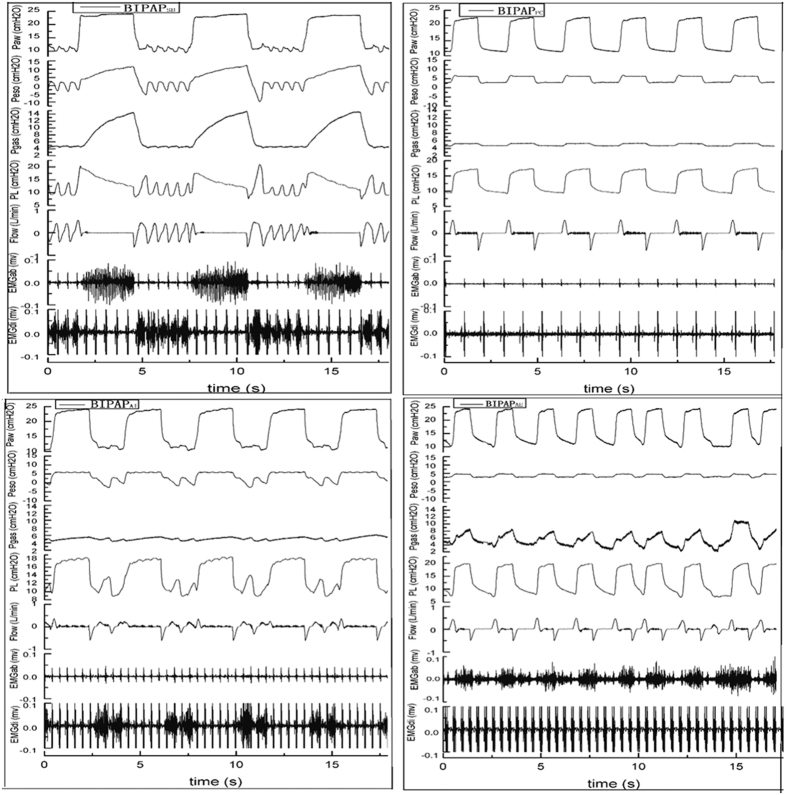
Representative respiratory tracings of airway pressure (Paw), esophageal pressure (Pes), intragastric pressure (Pgas), transpumonary pressure (PL), Airflow, abdominal muscles surface electromyography (EMGab) and diaphragmatic esophageal surface electromyography (EMGdi) in BIPAPSB, BIPAPPC, BIPAPAI and BIPAPAE group in representative animals.BIPAPSB = biphasic positive airway pressure with SB; BIPAPPC = biphasic positive airway pressure with muscles paralysis; BIPAPAI = biphasic positive airway pressure with inspiratory muscles activity; BIPAPAE = biphasic positive airway pressure with expiratory muscles activity.